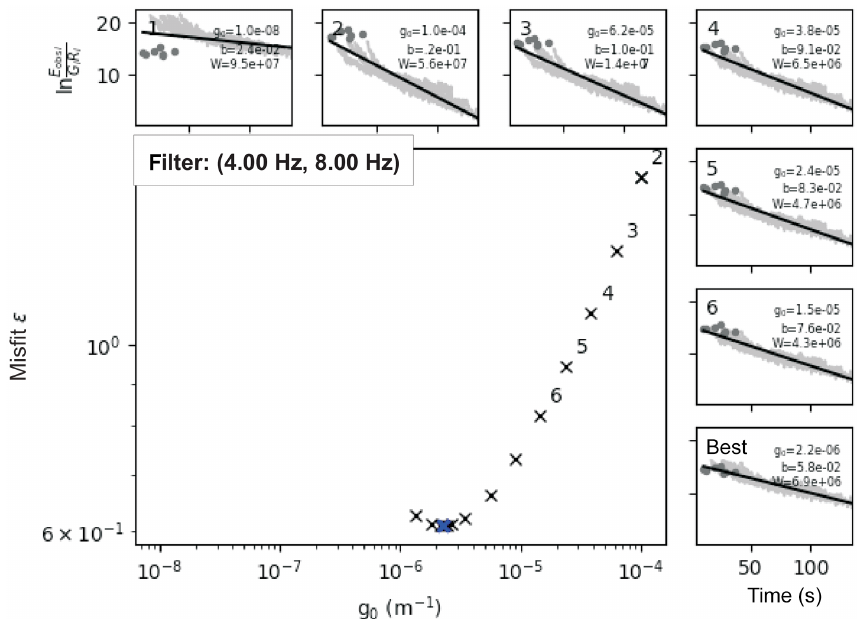
Figure 3. An example from the inversion procedure explained in Sect. 4. Here coda envelope fitting optimization is performed on band-pass- filtered (4–8Hz) digital recordings of an earthquake (9 April 2014, M w coda 3.2) extracted for seven seismic stations that operated within the CD–CAT array. The large panel displays the error function ε as a function of g 0 . The thick blue cross represents the optimal value of g = g 0 . The small panels show the least-squares solution of the weighted linear equation system for the first six guesses and the optimal guess for g 0 . The dots and gray curves indicate the ratio between energy ( E obs ) and the Green’s function ( G ) obtained for direct S waves and observed envelopes at various stations, respectively (please note that during this optimization process envelopes are corrected for the obtained site corrections R i ). The slope of the linear curve in each small panel yields − b in relation to the intrinsic attenuation. The linear curve has an intercept of W , representing source-related terms in the right-hand side of Eq.